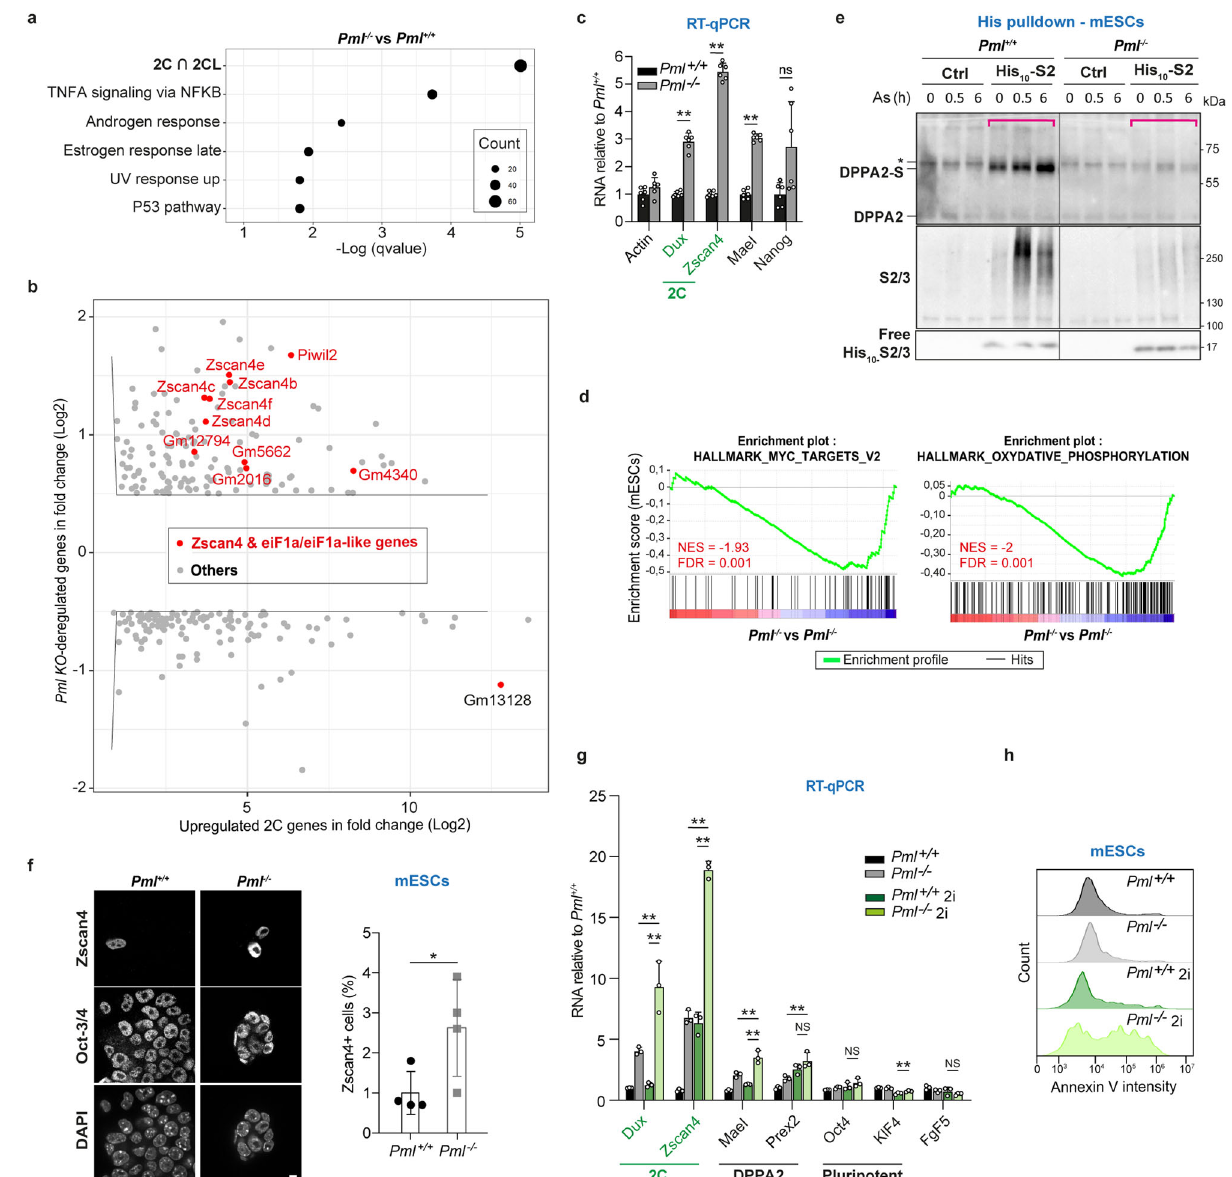
Fig. 5 | PML is required for 2CL transition and DPPA2 sumoylation in mESCs. a GSEAgene-settermenrichmentanalysisofthetranscriptsderegulatedin Pml − / − vs Pml +/+ mESCs from microarray analysis; 2C ∩ 2CL geneset: transcripts common to 2Cembryoand2CLcellsfrom(ref.49). b Transcriptsde-regulatedin Pml − / − vsPml +/+ mESCs, related to upregulated genes in 2C embryo vs oocytes 49 . Transcripts with signi fi cant changes (gray) and key 2CL genes (red) are shown from microarray analysis (Supplementary Data 6). c Mean fold increase of the indicated 2CL tran- scriptsandMaeIasadirecttargetofDPPA2(qRT-PCR) n =6independentbiological replicates, normalized on gapdh and relative to values in Pml +/+ mESCs, +/ − SD, ** p <0.01, two-tailed unpaired Mann – Whitney test. Representative of the three CrispR/Cas9 Pml − / − clones. d GSEA analyses of RNAseq from Pml − / − vs Pml +/+ mESCs unraveling Myc targets and Oxidative phosphorylation as the top two altered